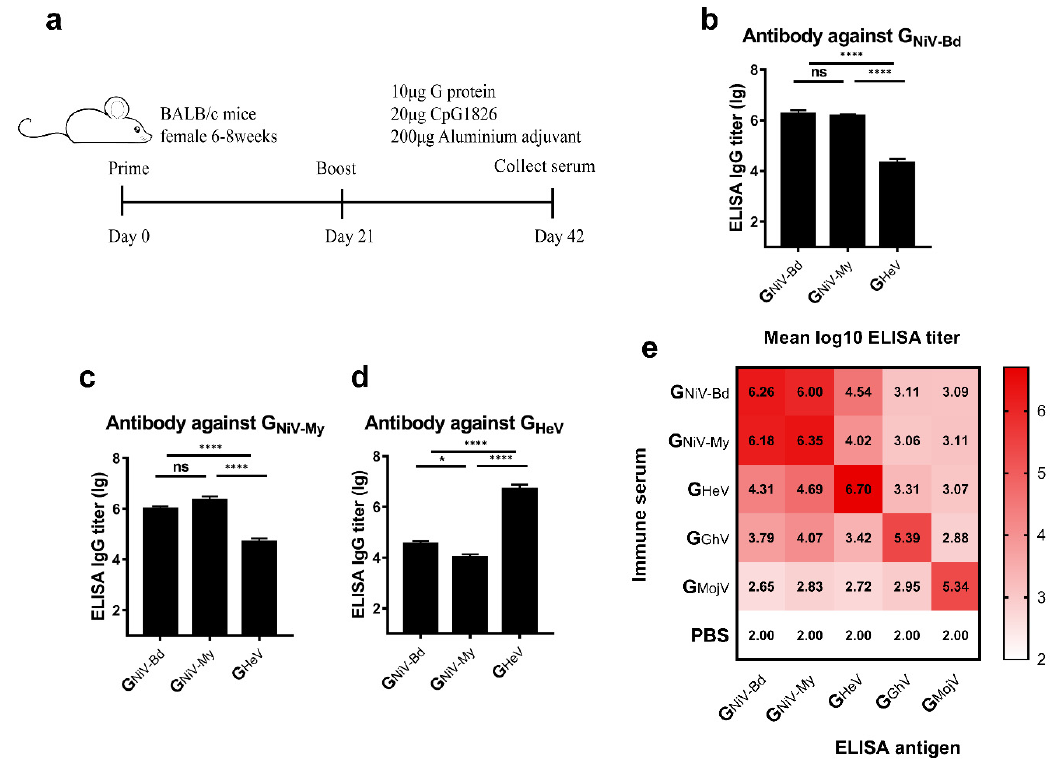
Figure 2. Cross-reactive specific antibody response induced by G proteins. ( a ) BALB / c mice (6–8 weeks, female, N = 10 per group) were immunized intramuscularly with 10 µ g G NiV-My , G NiV-Bd , G HeV , G GhV , G MojV , or PBS at weeks 0 and 3. The adjuvants added were 200 µ g of aluminum hydroxide and 20 µ g of CpG1826. At 42 days after immunization, the mice were sacrificed, and the serum was collected. Specific antibodies against G proteins in the serum were detected by an enzyme-linked immunosorbent assay (ELISA). ( b ) Antibody titers against G NiV-Bd . ( c ) Antibody titers against G NiV-My . ( d ) Antibody titers against G HeV . The mean log10 ELISA titer ± SEM is shown. Student’s t test was performed for all comparisons, and a P -value < 0.05 was considered statistically significant; * 0.01 < P -value < 0.05; **** P -value < 0.0001. ( e ) Matrix graph of the cross-reactive antibody responses elicited by the HNV-G proteins. The data are presented as the mean log10 ELISA titers. Same data is used in more than one panel.